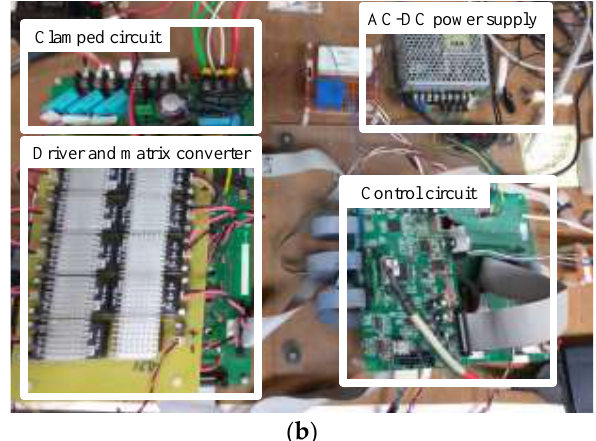
Figure 9. The implemented matrix-converter PMSM drive system. ( a ) Block diagram, ( b ) photo of matrix-converter.